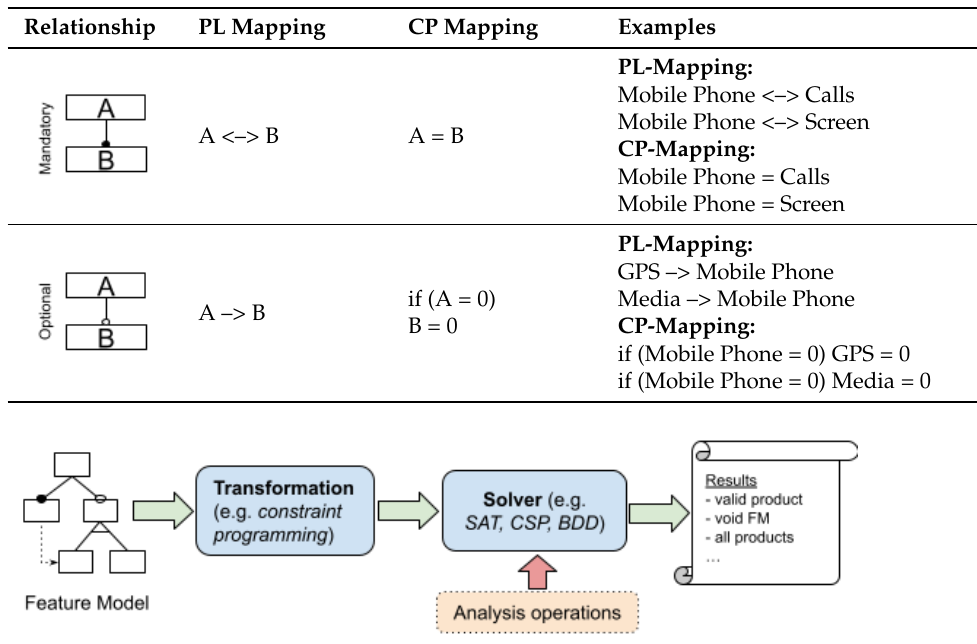
Table 3. Summary of representations of relationships of FMs.